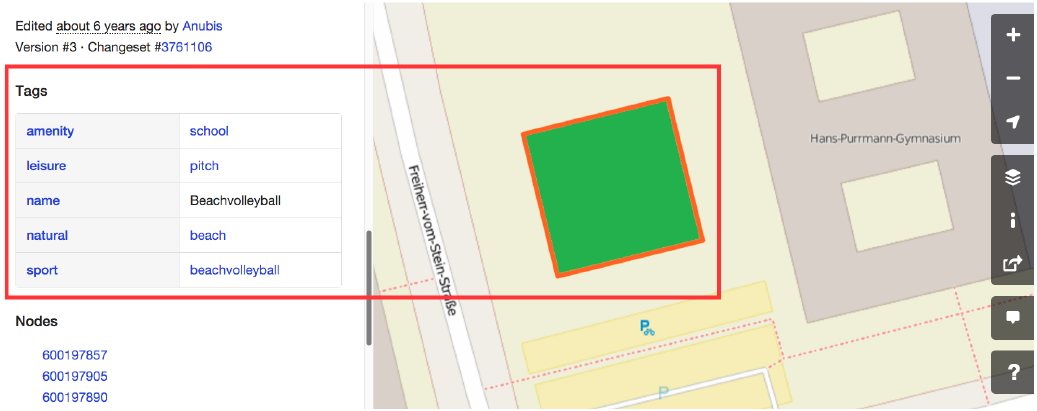
Figure 1. An example of problematic classification in the OSM project: the highlighted entity is classified as pitch, school , and beach , while it is actually a beach volleyball playground in a